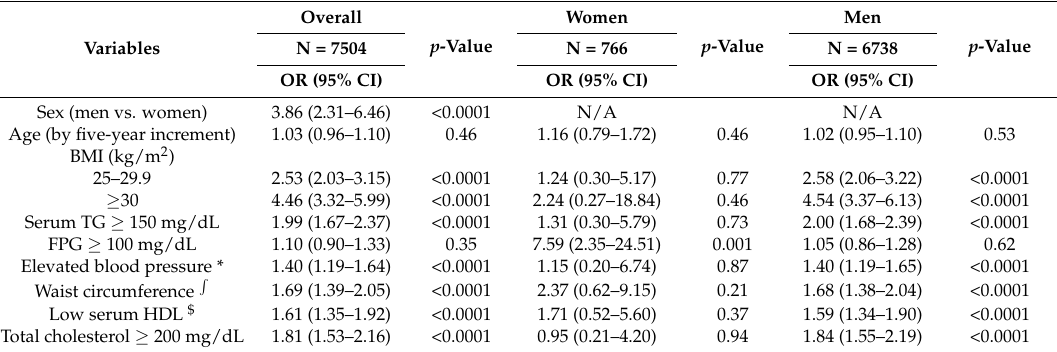
Table 4. Multivariate analysis of the metabolic risk factors predicting elevated ALT ≥ 40 U/L based on sex.